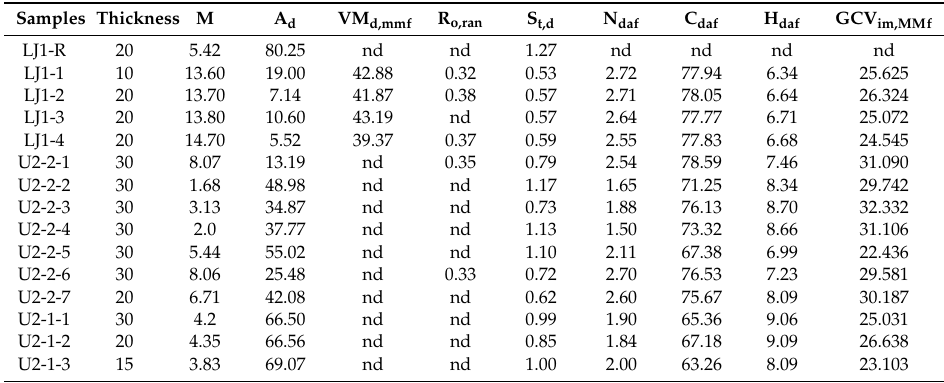
Table 1. Proximate and ultimate analysis (%), thickness (cm), total sulphur (%) and gross calorific value (MJ / kg) of the coals and oil shales from Liangjia Coalmine, Huangxian Basin. Samples Thickness